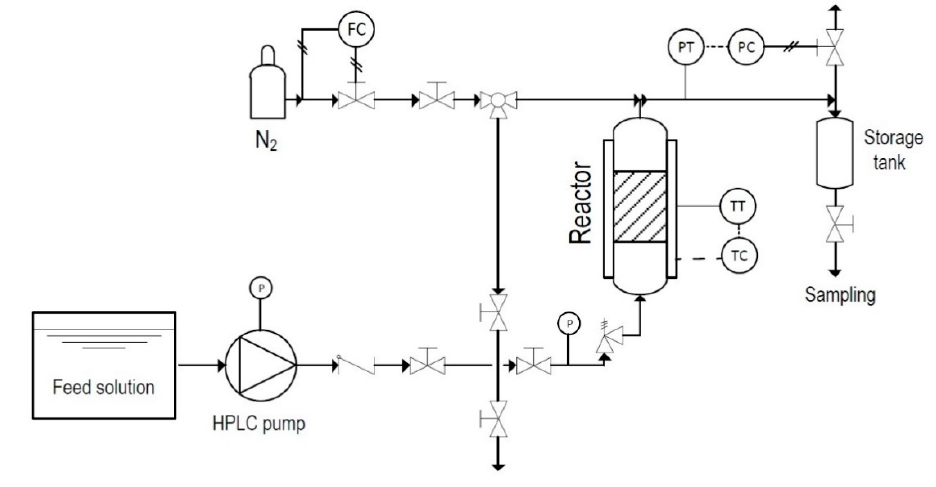
Figure 6. Schematic representation of the flow reactor system.